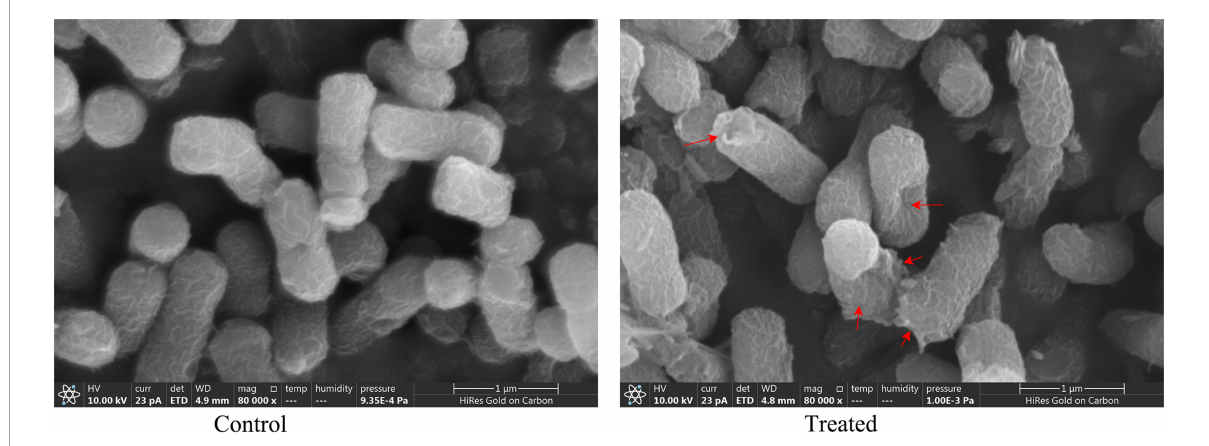
FIGURE7 Morphological changes in E. coli treated with PBS and 2 × MIC BVYA1. Indentations in the cell membrane are indicated by red arrows.